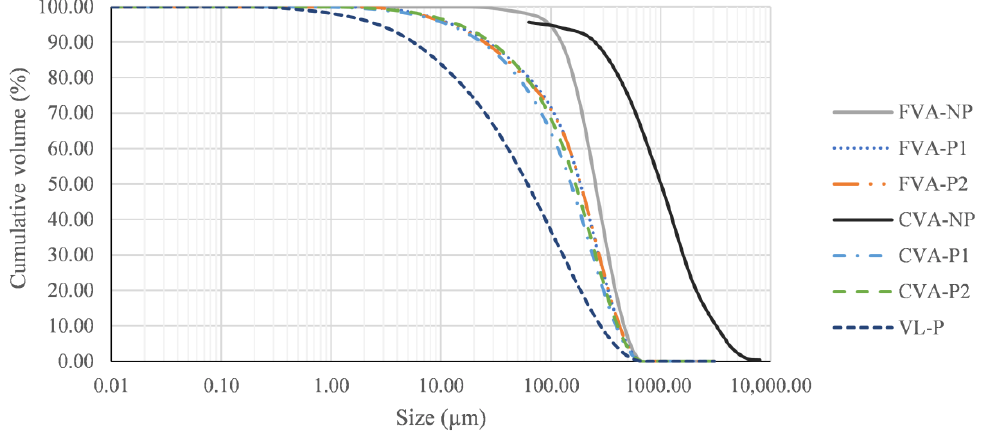
Figure 7. Particle size distribution of raw and processed VA and